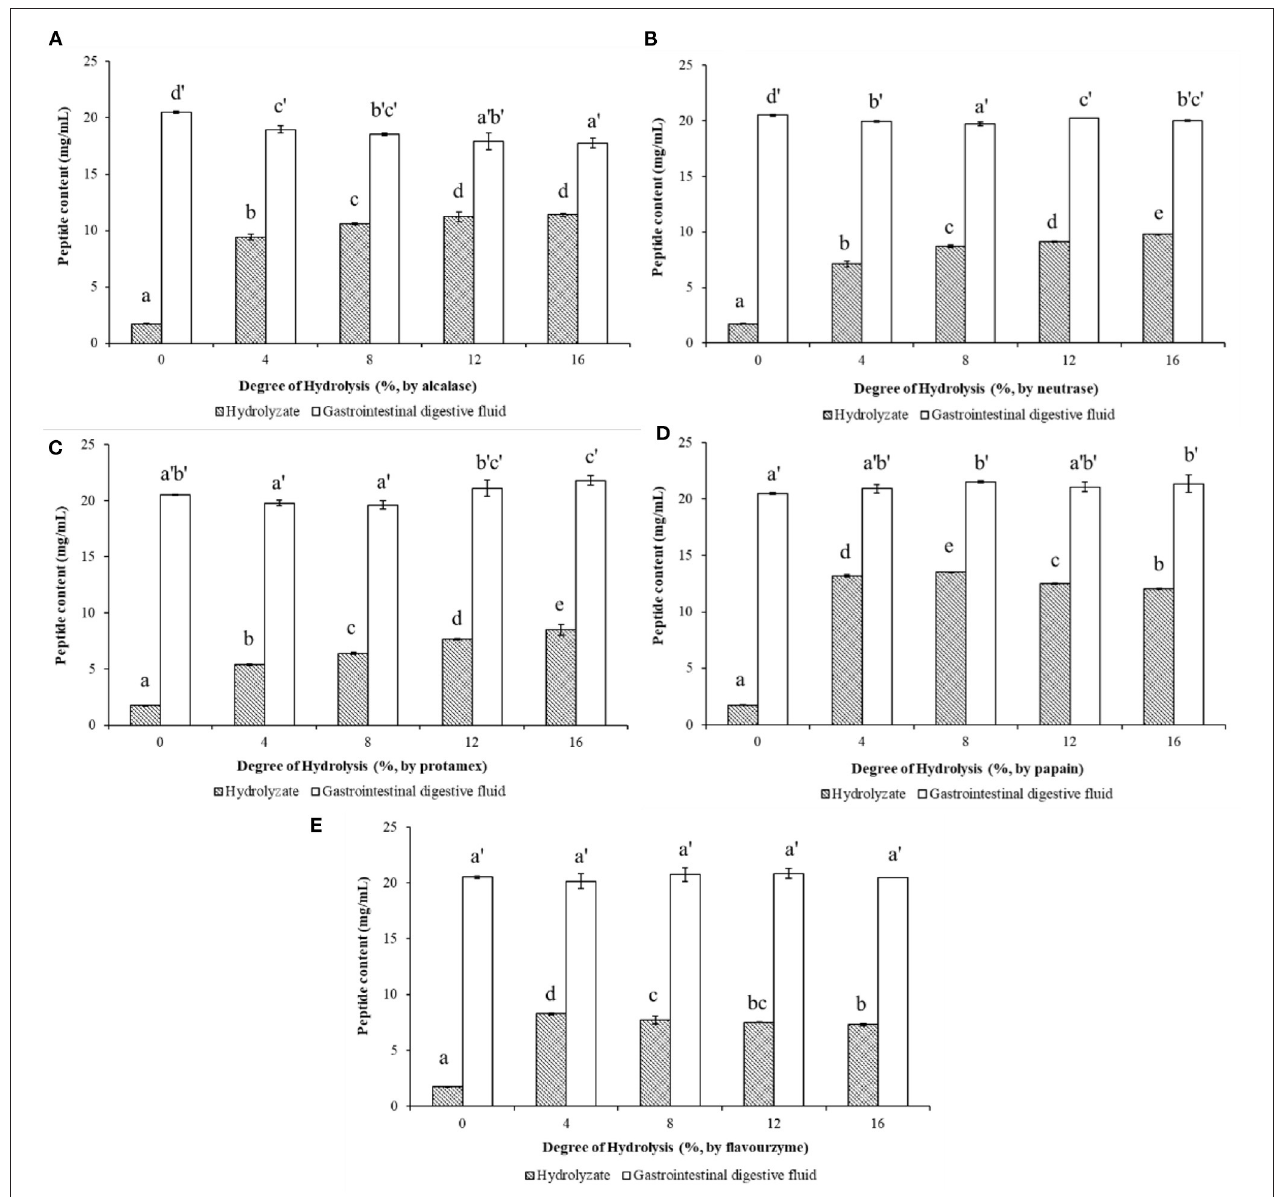
FIGURE 2 | Peptide contents of walnut protein hydrolysates before and after the simulated gastrointestinal digestion in vitro . (A) Walnut protein hydrolysate produced by alcalase; (B) Walnut protein hydrolysate produced by neutrase; (C) Walnut protein hydrolysate produced by protamex; (D) Walnut protein hydrolysate produced by papain; (E) Walnut protein hydrolysate produced by flavourzyme. The results are expressed as mean ± SD ( n = 3). Means with different superscripts are significantly different ( p <